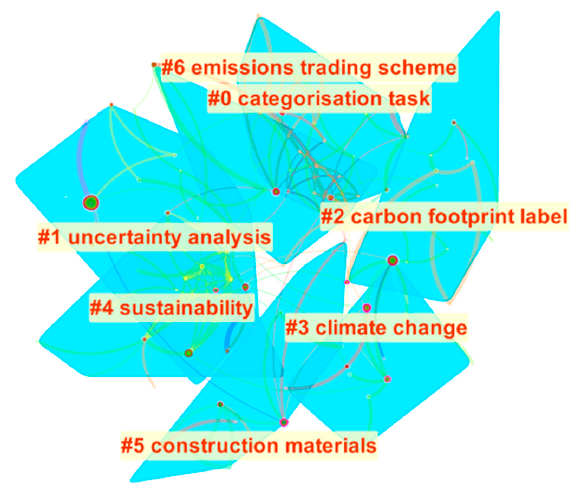
Figure 6. Clusters of carbon label studies related keywords.